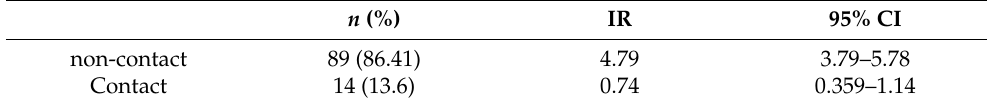
Table 5. Percentage of injuries, injury rate (IR, number of injuries per 1000 h of exposure), 95% confidence intervals (CI) for contact and non-contact injuries, and corresponding injury mechanisms. n